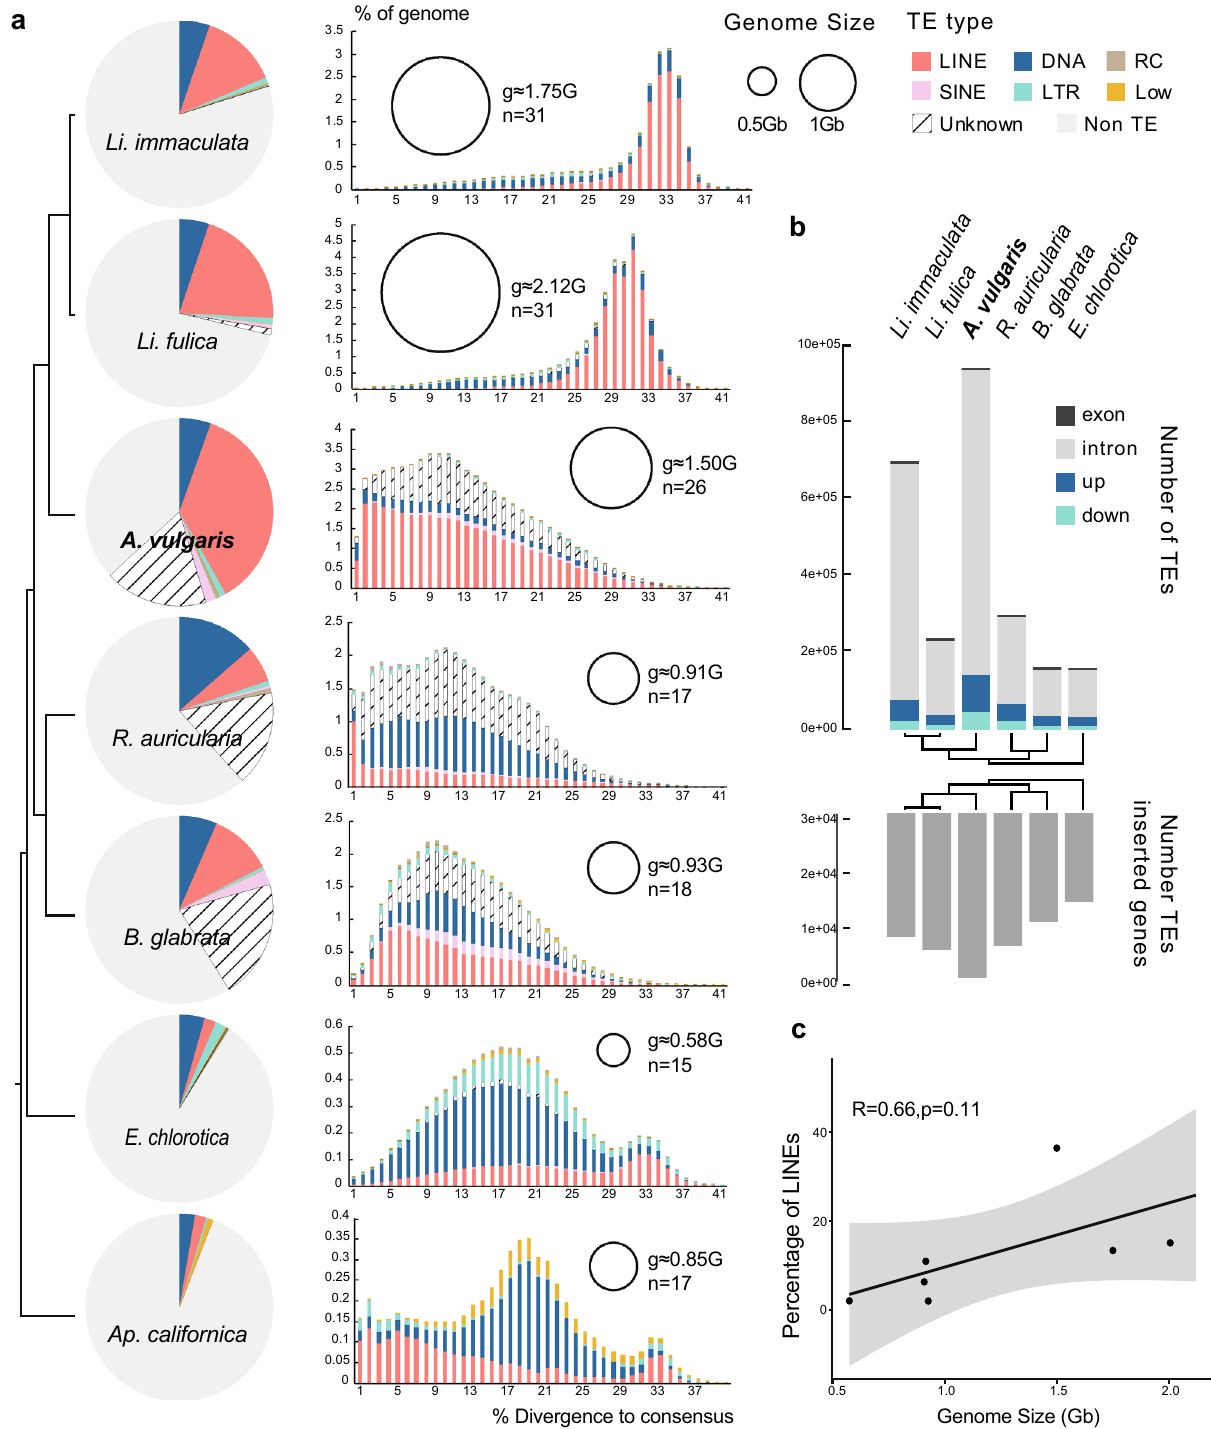
Figure 5. Massive expansion of transposable elements (TEs) in Arion vulgaris genome. ( a ) Left: TE composition by class among Heterobranchia species. Right: TE accumulation history corresponding to each species. The size of the circle indicates the estimated genome size of each species. n represents the number of haploid chromosomes; g represents the estimated genome size. ( b ) Bar graph shows the number of TEs in different genic regions and the number of TEs-inserted genes in each species. ( c ) Relationship between LINEs coverage and genome size in Heterobranchia species. Numbers on linear regressions correspond to adjusted r 2 coefficients (Pearson’s